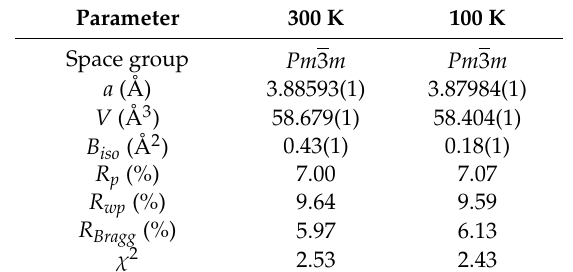
Table 1. Results of Rietveld refinements of the crystal structure of Eu 0.8 Ca 0.2 TiO 3– δ at 300 K and 100 K.